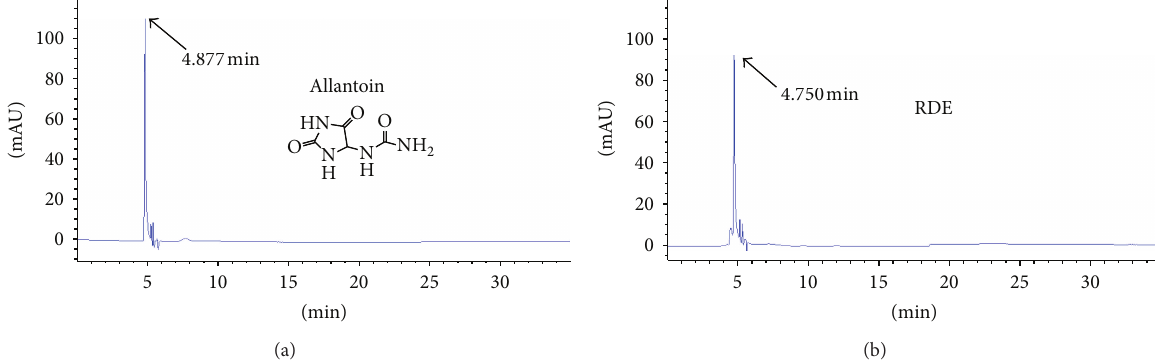
Figure 1: HPLC for the qualitative analysis of allantoin in the RDE. The chromatograms for standard substances and RDE are shown in (a) and (b), respectively. ((a) and (b)) The chromatograms for standard substances of allantoin and RDE,